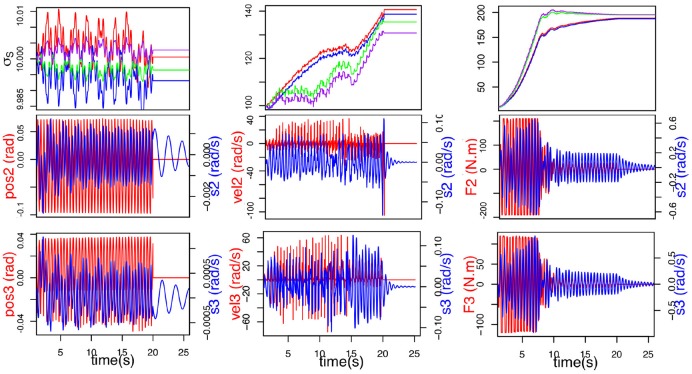
Comparison of different efferent articular signals to the CPG during handshaking: position (Left), velocity (Middle), and torque (Right). Evolution of σs (top) (σS2E (blue), σS2F (red), σS3E (purple) and σS3F (green)), F(t) in red (middle and bottom), and articular velocity in blue.